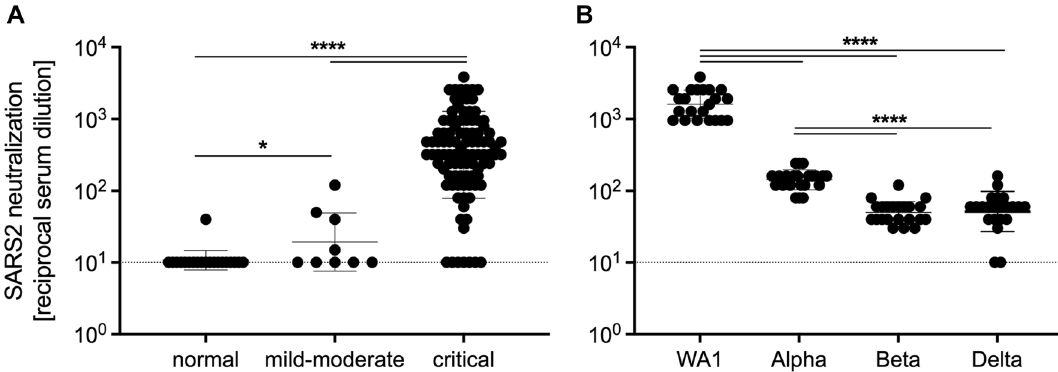
Figure 4. Critical COVID-19 induces high titers of SARS-CoV-2 neutralizing antibodies. ( A ) SARS-CoV-2- specific neutralizing antibody titers for COVID-19 and normal serum samples against SARS-CoV-2 USA-WA1. ( B ) Neutralizing antibody titers for COVID-19 serum samples comparing SARS-CoV-2 variants USA-WA1, Alpha, Beta, and Delta. Geometric mean and geometric SD are shown. Statistically significant differences as determined by Mann–Whitney test are indicated as p < 0.0001 (****), and p < 0.05